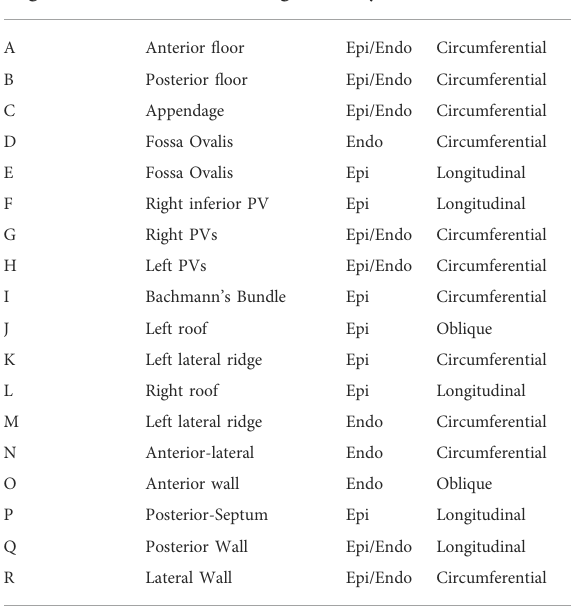
TABLE 1 Description of subregions shown in Figure